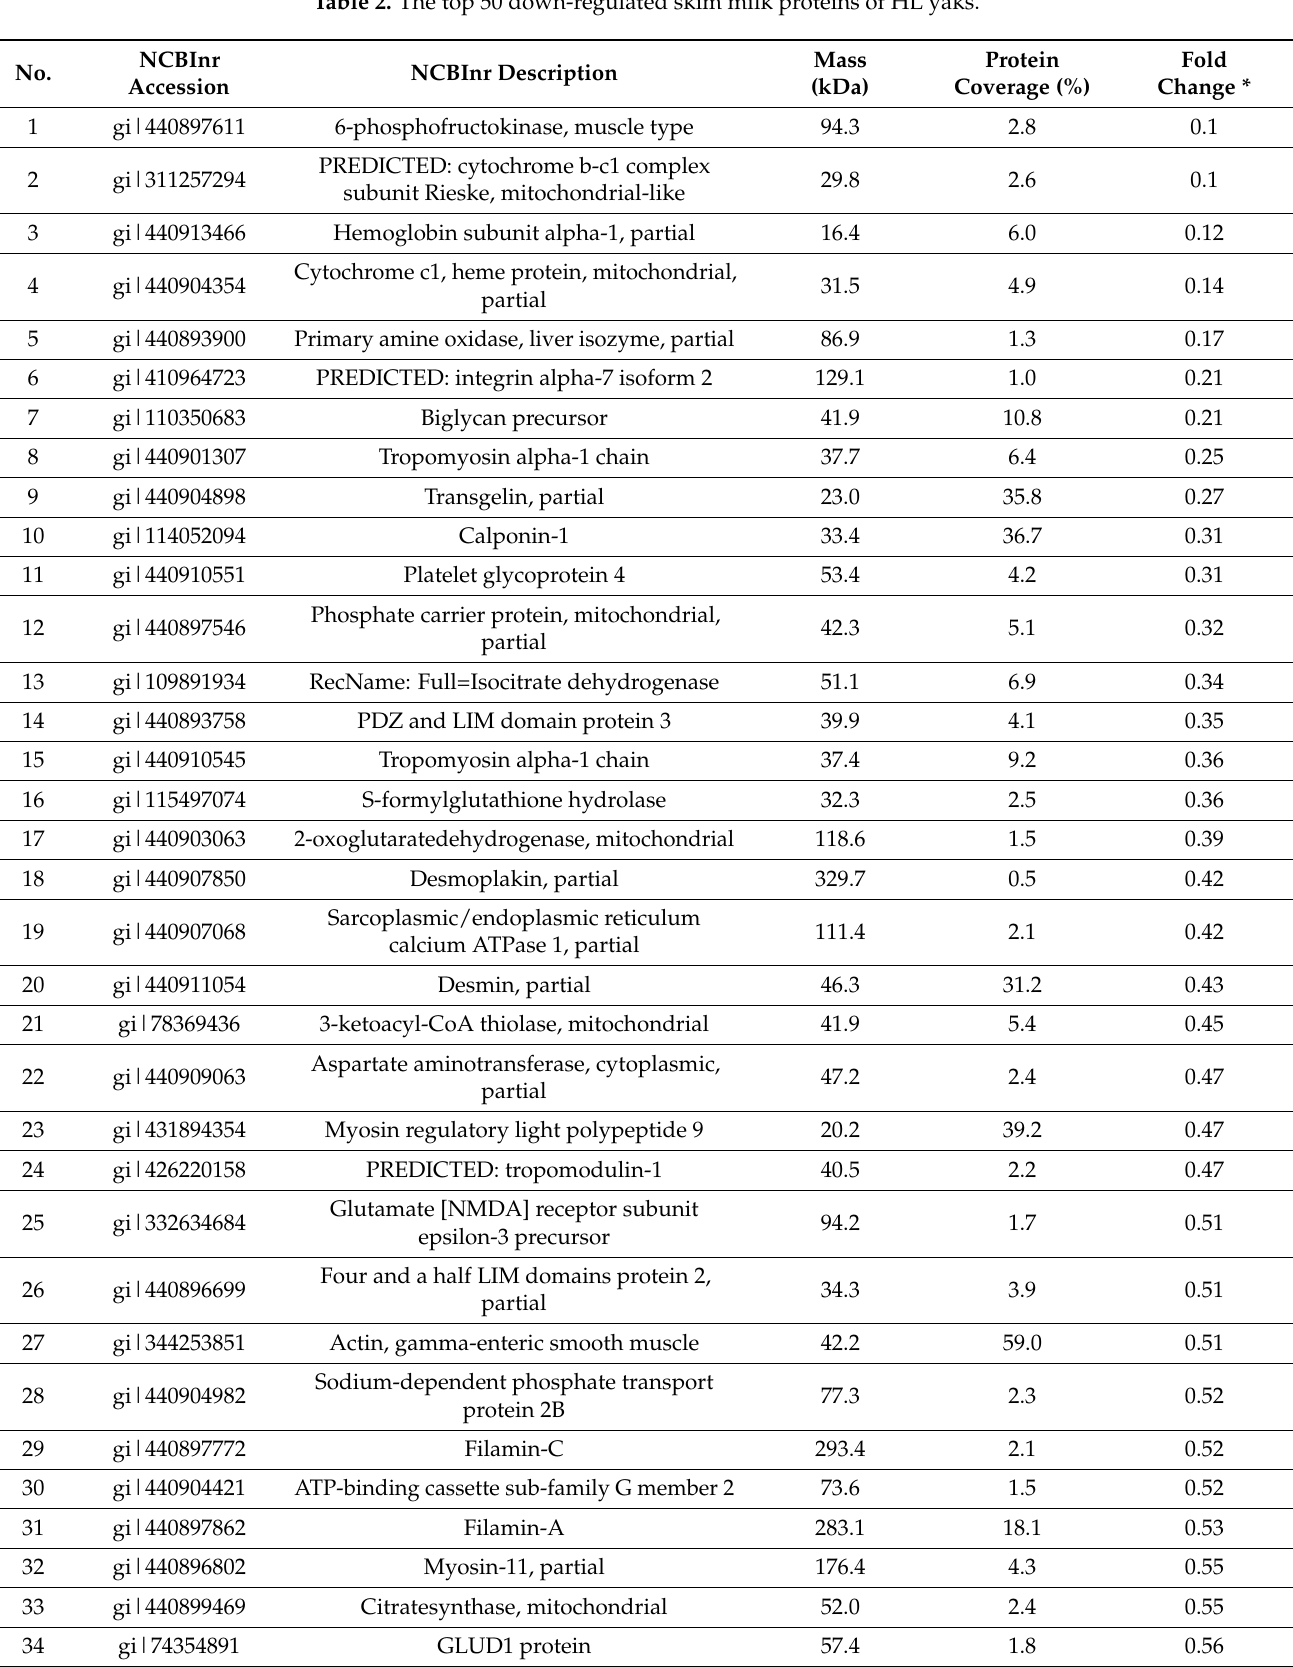
Table 2. The top 50 down-regulated skim milk proteins of HL